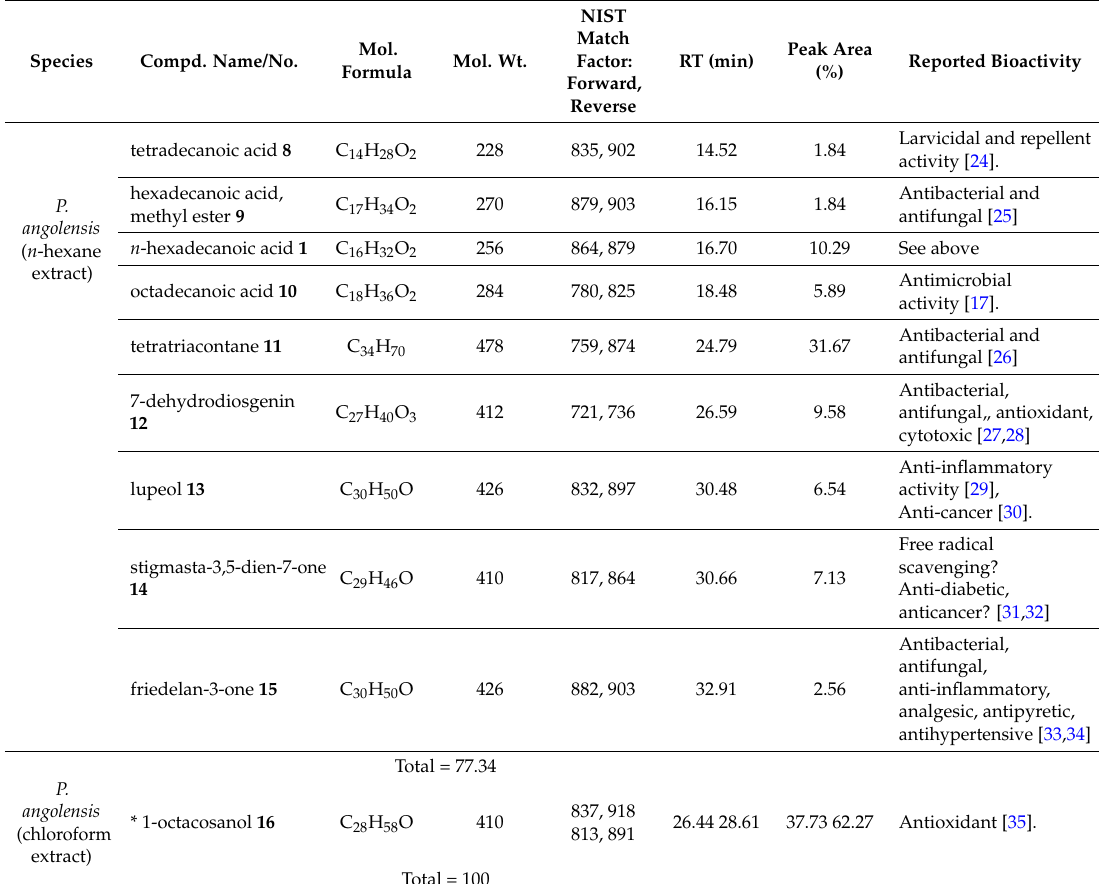
Table 2. Phytocomponents identified from the stem bark of P. angolensis by GC-MS analysis. Species Compd. Name/No.